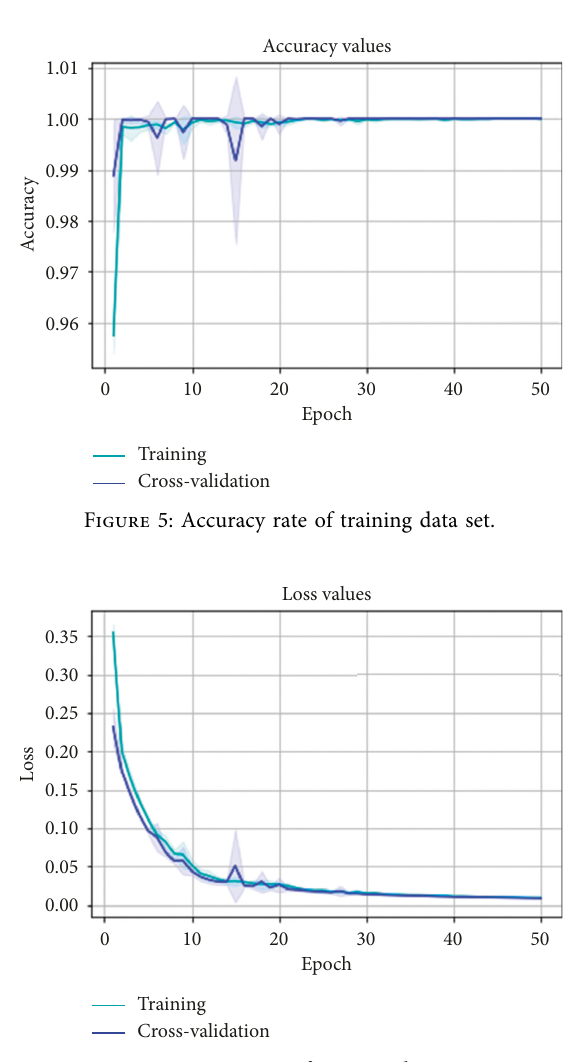
Figure 6: Loss rate of training data